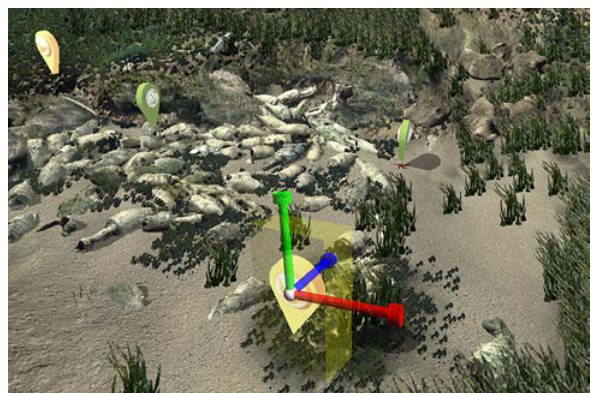
Figure 7. Adding a 3D object of a POI in the virtual